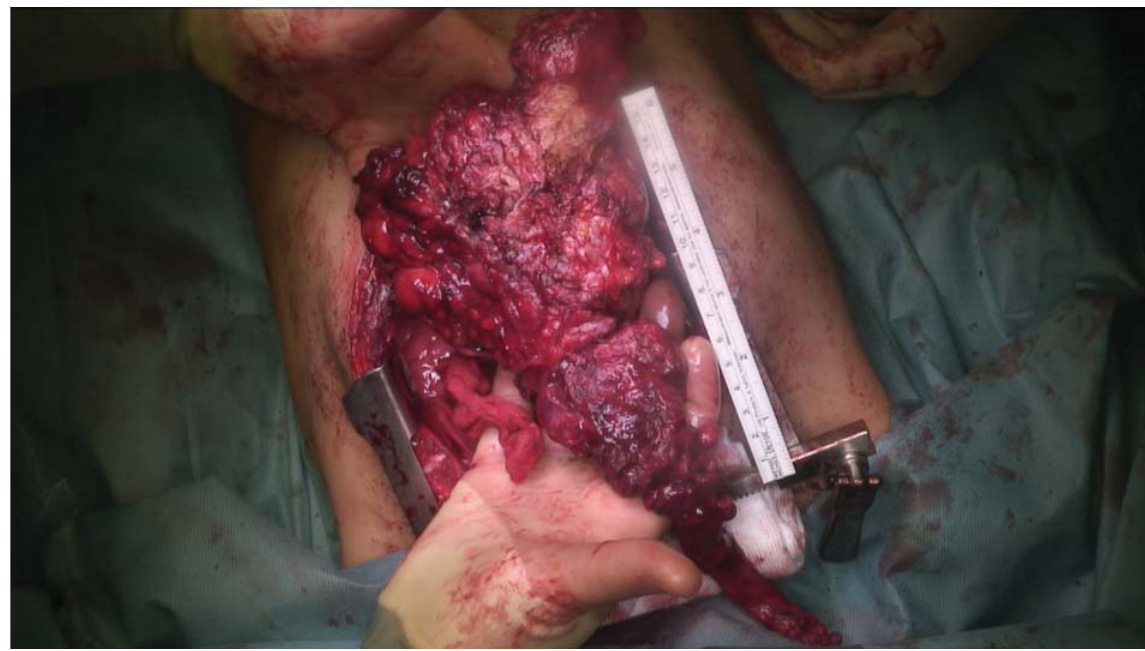
Fig. 2 Clinical appearance of the calcifying fi brous tumor during median